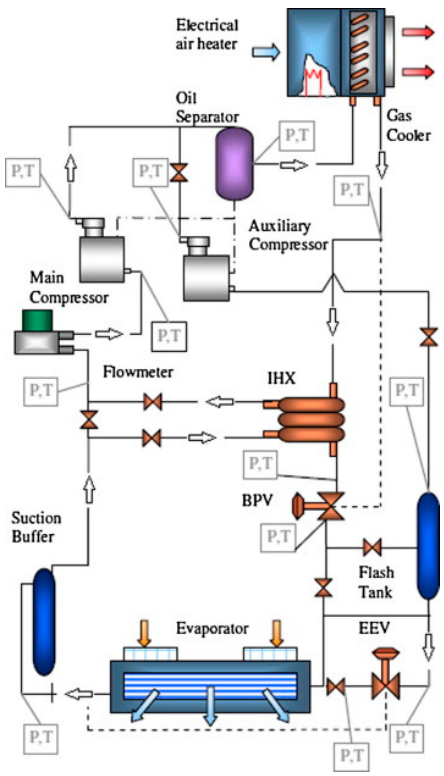
Figure 1. Schematic of the experimental setup used for the experiments [29]. P and T represent the positions of the pressure and temperature sensors,